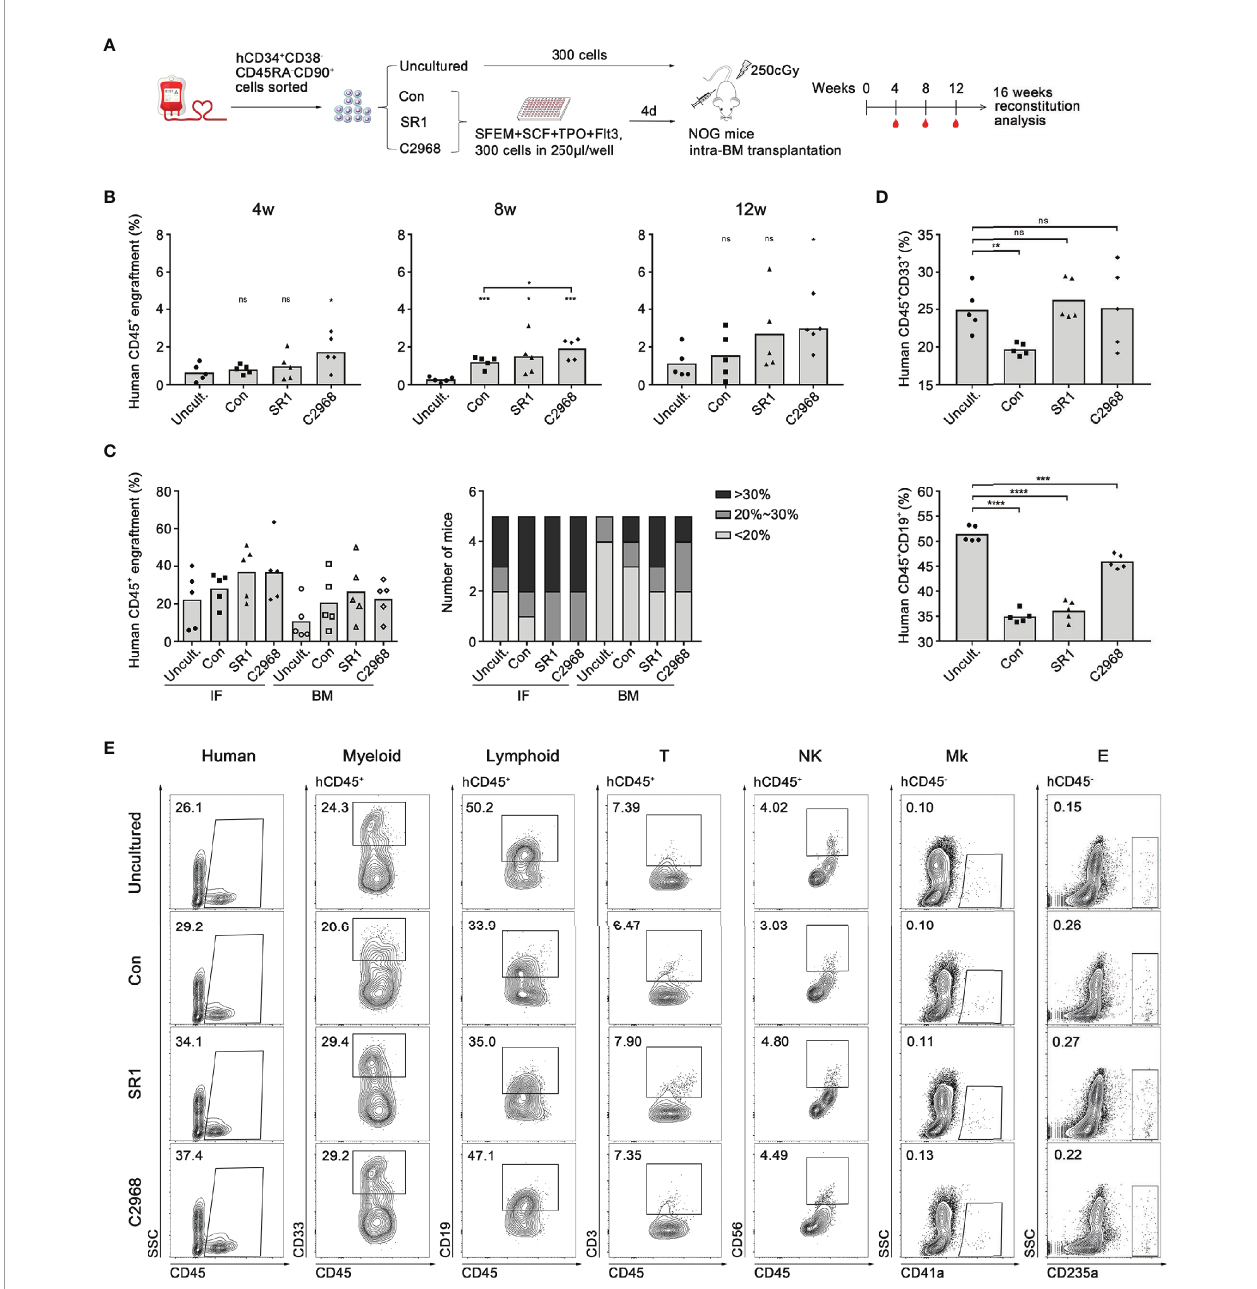
FIGURE 3 | Analysis of the effect of chrysin treatment on human hematopoietic cell engraftment and reconstitution in NOG mice. (A) Transplantation strategy with uncultured or ex vivo expanded human CD34 + CD38 − CD45RA − CD90 + cells. Uncultured cells were transplanted into NOG mice on day 0 and cultured cells derived from 300 input cells were transplanted in to NOG mice on day 4. (B) Levels of human cell engraftment in peripheral blood (PB) of NOG mice at 4, 8, or 12 weeks post-transplantation. (n = 5 mice per group) (C) Levels of the engrafting human cells (hCD45 + ) in the injection side bone marrow (IF) and the opposite side bone marrow (BM) at 16 weeks post-transplantation. Number of mice at different engraftment levels (< 20%; 20%~30%; > 30%) in each group were shown. (D) Levels of the reconstituting myeloid (hCD45 + CD33 + ) and lymphoid (hCD45 + CD19 + ) in the injection side and the opposite side bone marrow at 16 weeks post- transplantation. (E) Representative fl ow cytometric pro fi les of the engrafting human CD45 + cell and myeloid, lymphoid, T lymphocyte (hCD45 + CD3 + ), natural killer cell (NK, hCD45 + CD56 + ), megakaryocyte (Mk, hCD45 − CD41a + ), and erythroid (E, hCD45 − CD235a + ) reconstitution in BM 16 weeks post-transplantation. All data represent the means ± SD. Compared with uncultured group unless speci fi ed, *p < 0.05, ***p < 0.001, ****p < 0.0001 and ns, no signi fi cance by two-tailed unpaired t-test. ● , ■ , ▲ and ♦ represent a single data point in Uncultured (Uncult.), Con, SR1 and C2968 groups respectively in (B, D) . ● , ■ , ▲ and ♦ represent a single data point of IF in Uncult., Con, SR1 and C2968 groups respectively while ○ , □ , D and ◊ represent those of BM in (C)